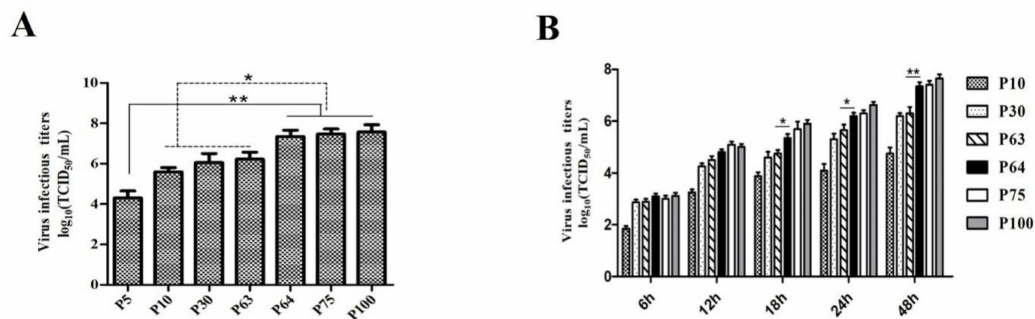
Figure 2. Growth kinetics of SDSX16 in Vero cells. ( A ) Virus titers of di ff erent passages. Vero cells were infected with PEDV SDSX16 and harvested at indicated passage numbers. At 48 h of infection for each passage, supernatants were collected and virus titers were determined. Data are shown as mean ± SEM (* p < 0.05, ** p < 0.01) ( B ) One-step growth for SDSX16. Vero cells were infected with PEDV SDSX16 (P10, P30, P63, P64, P75, P100), and at the indicated time points, post-infection, culture supernatants were harvested and virus titers were determined. The 50% tissue culture infectious dose (TCID 50 ) was calculated. Results are expressed as the mean values from triplicate wells. Data are shown as mean ± SEM (* p < 0.05, ** p <